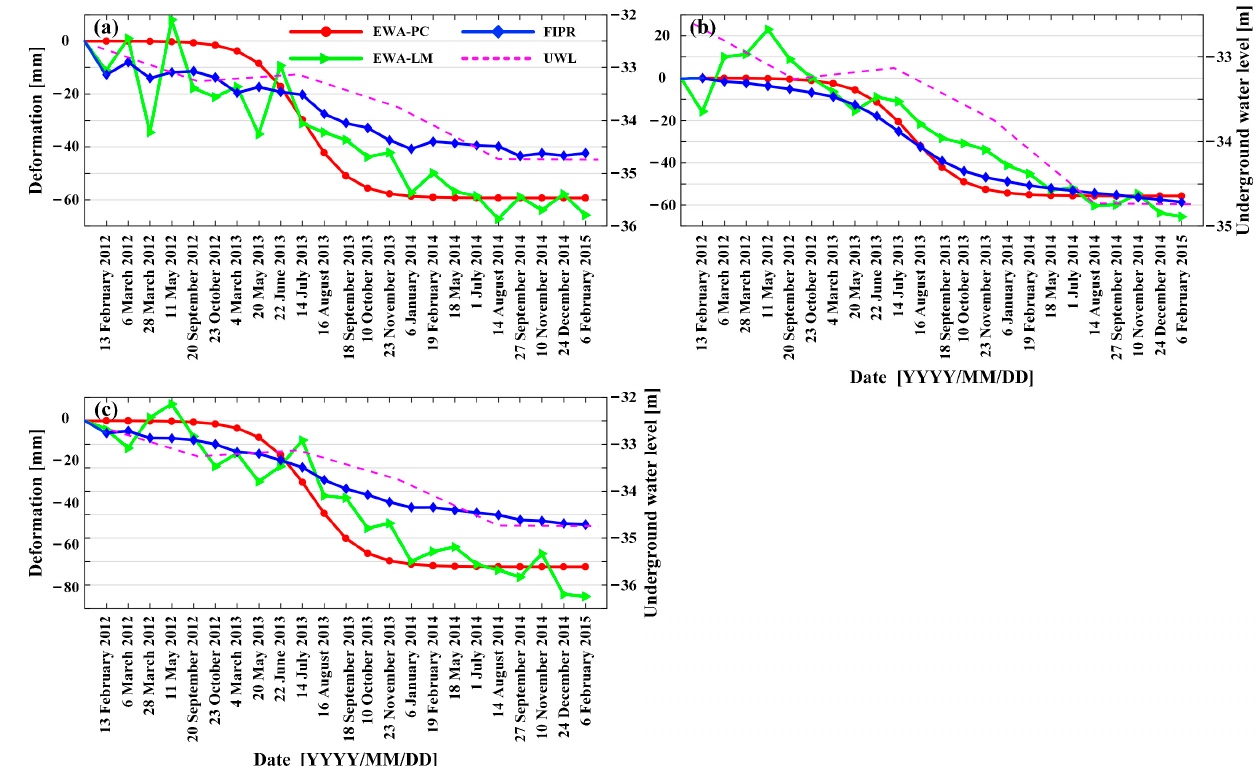
Figure 9. Correlation analysis between the time-series deformation results and the elevations of groundwater level (EWA-LM: linear model with equal weight accumulation; EWA-PC: Poisson curve with equal weight accumulation; UWL: elevation of groundwater level) at ( a ): P1; ( b ): P2; ( c ): P3.